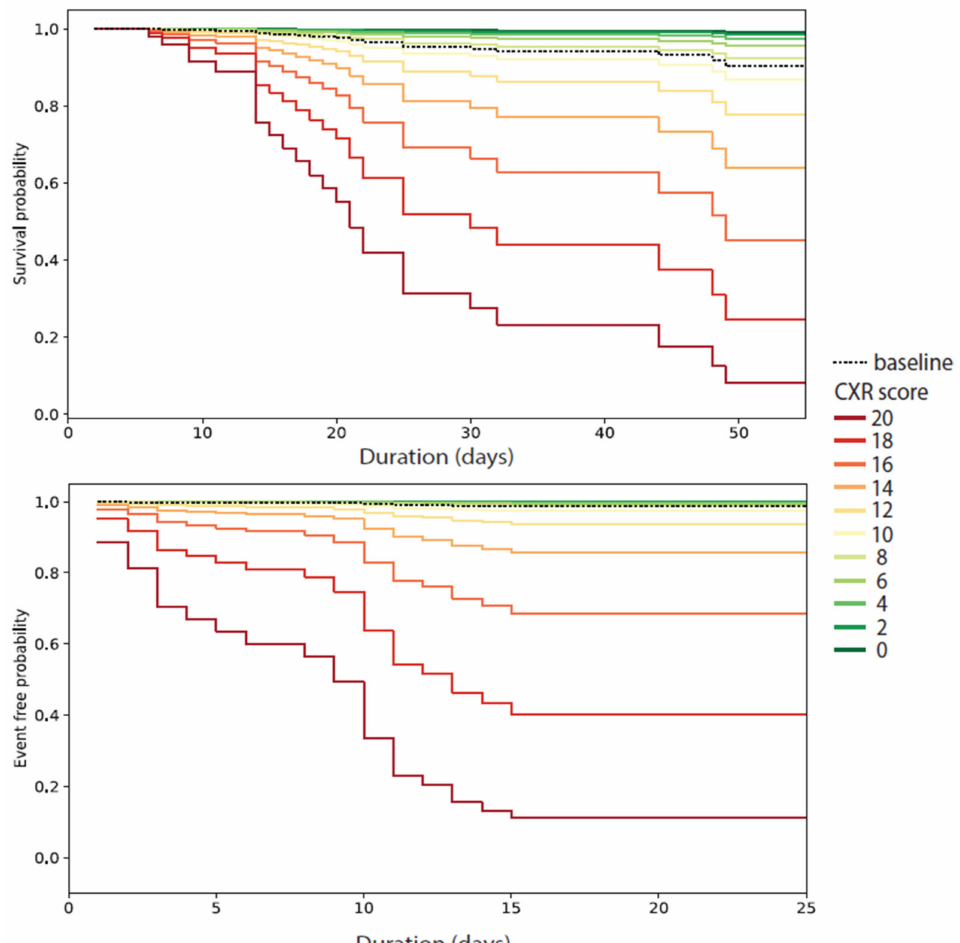
Figure 2. The effect of CXR score ranging from 0 to 20 on the survival and ICU admission event function. Note that only in-hospital mortality was taken into account.